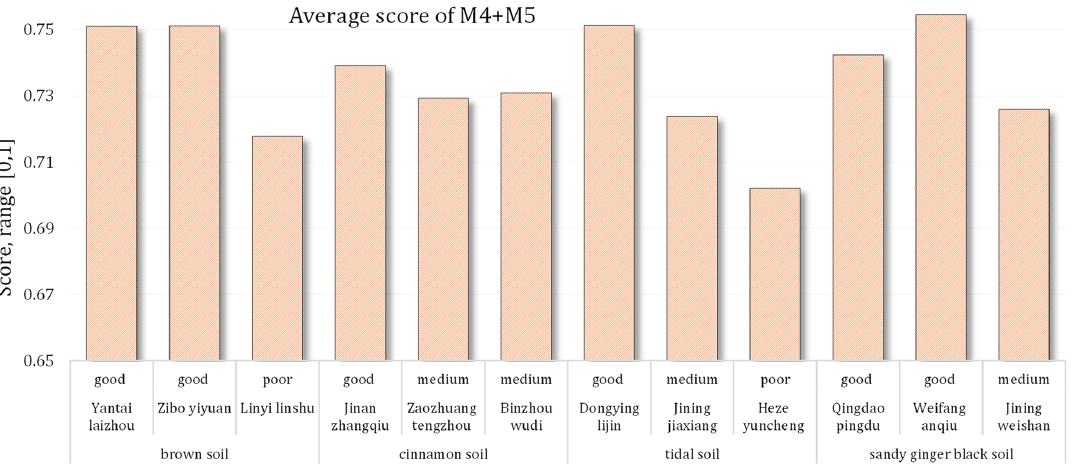
Figure 6. Average score of M4 + M5.